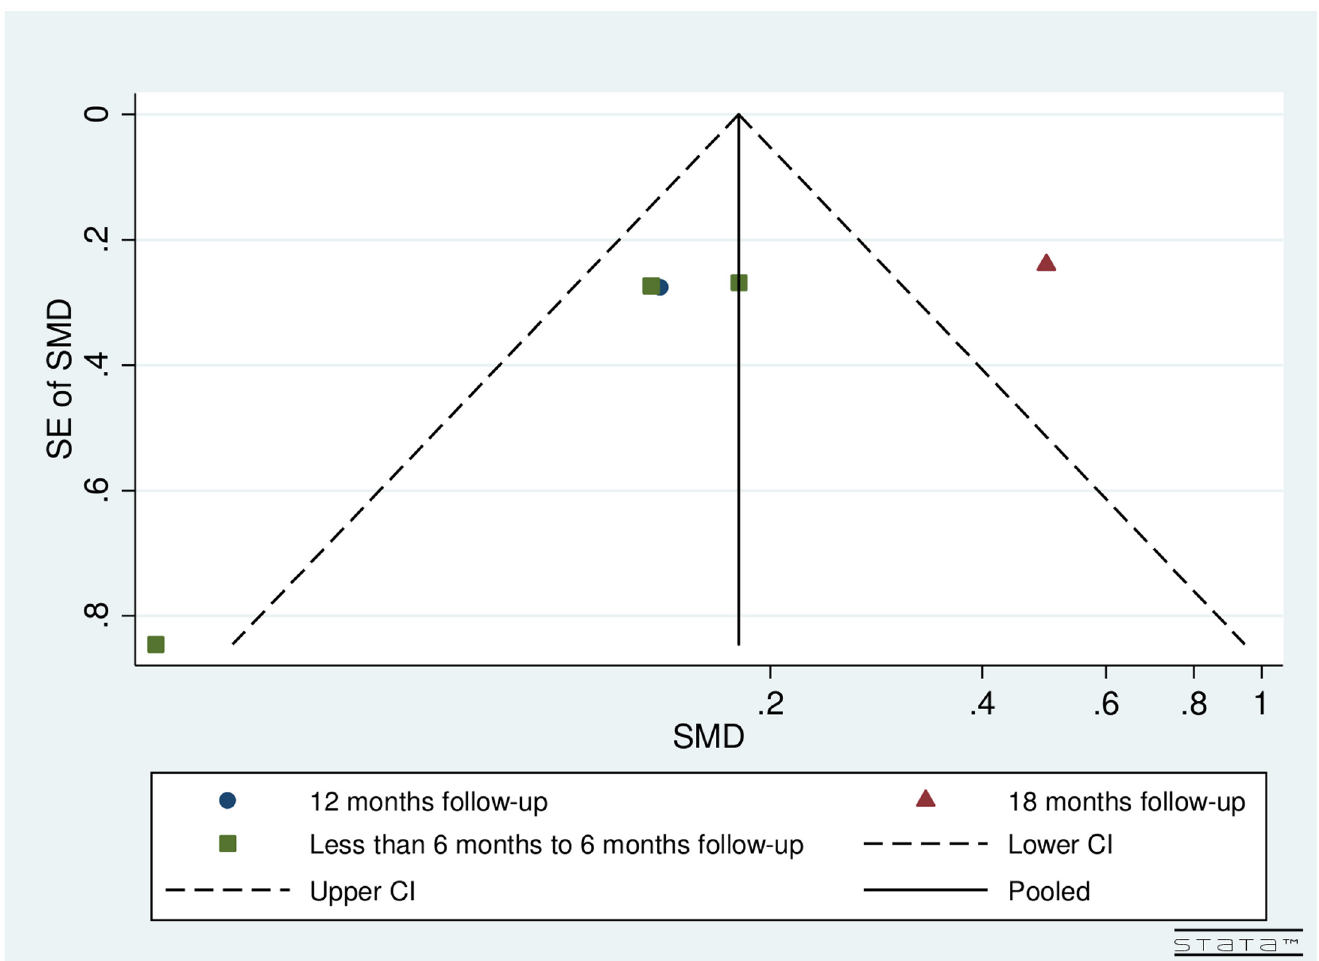
Fig 4. Funnel plot for studies examining pre- and post-operative number of medications by follow-up (months).